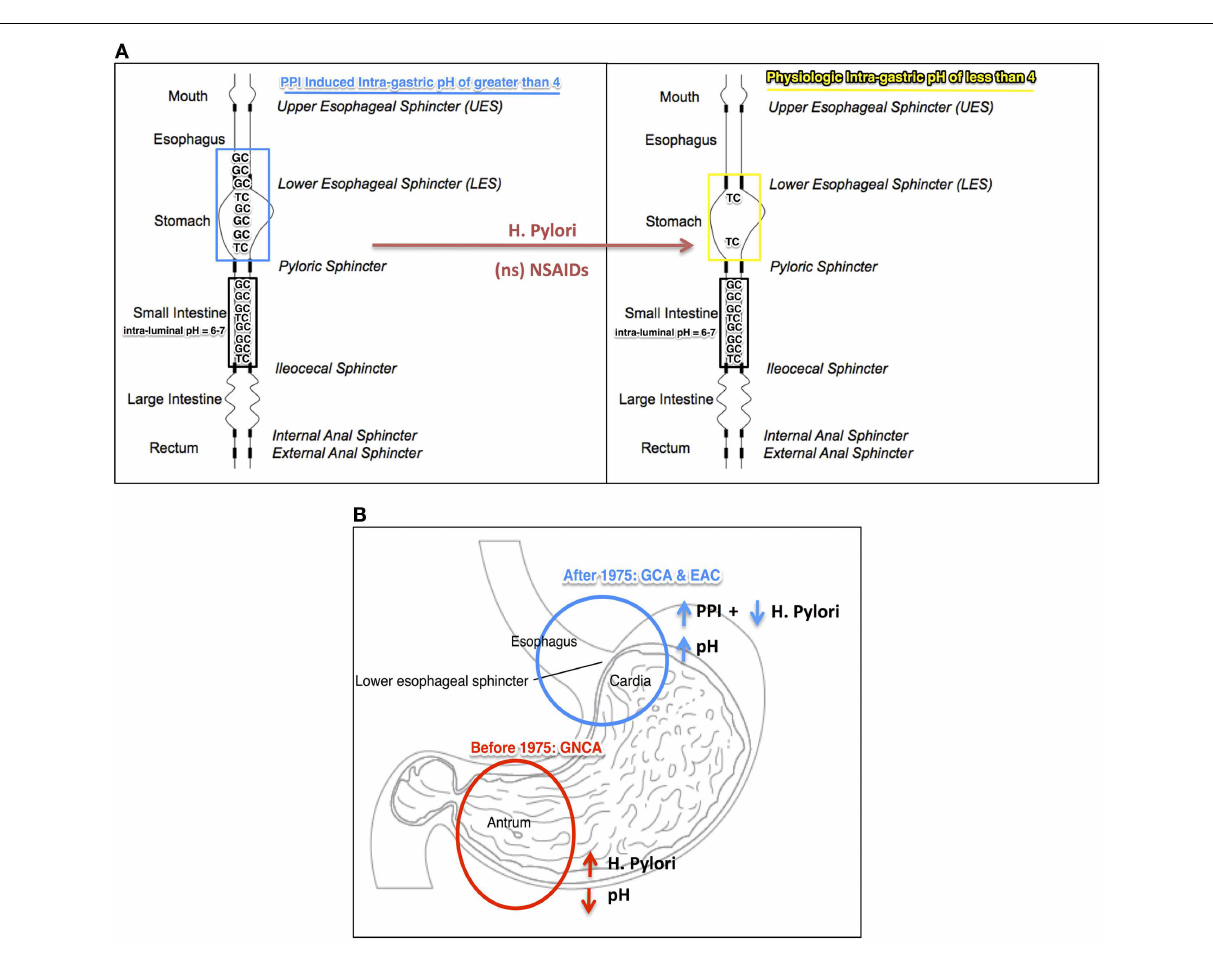
FIGURE 1 | (A) Illustration of the “ion-trapping concept”: [intra-gastric pH (PPI induced or physiologic) = pKa (TC or GC) + log (IonizedTC or GC/Un-ionizedTC or GC)] in which intra-gastric pH, PPI induced (blue) and physiological (yellow), facilitates movement of tauroconjugates (TC, pKa 2) and/or glycol-conjugates (GC, pKa 3.7) from the duodenum to the esophagus.When the intra-gastric pH is > 4 (PPI induced), theoretically, 4 times more of the amount of ionized bile salts may mobilize to the esophagus. Helicobacter pylori (HP) and non-specific (ns) NSAID may